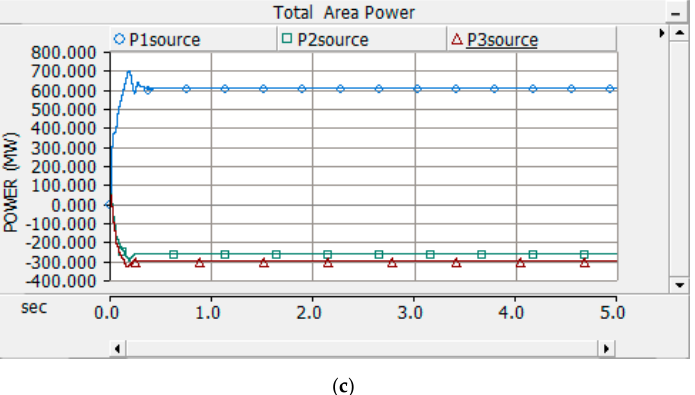
Figure 10. Power flow at power angle of 45°: ( a ) AC power flow in area-1, area-2, and area-3 as P 1ac , P 2ac , and P 3ac , respectively; ( b ) DC power flow in area-1, area-2, and area-3 as P 1dc , P 2dc , and P 2dc , respectively; ( c ) total power flow in area-1, area-2, and area-3 as P 1source , P 2source , and P 3source , respectively.